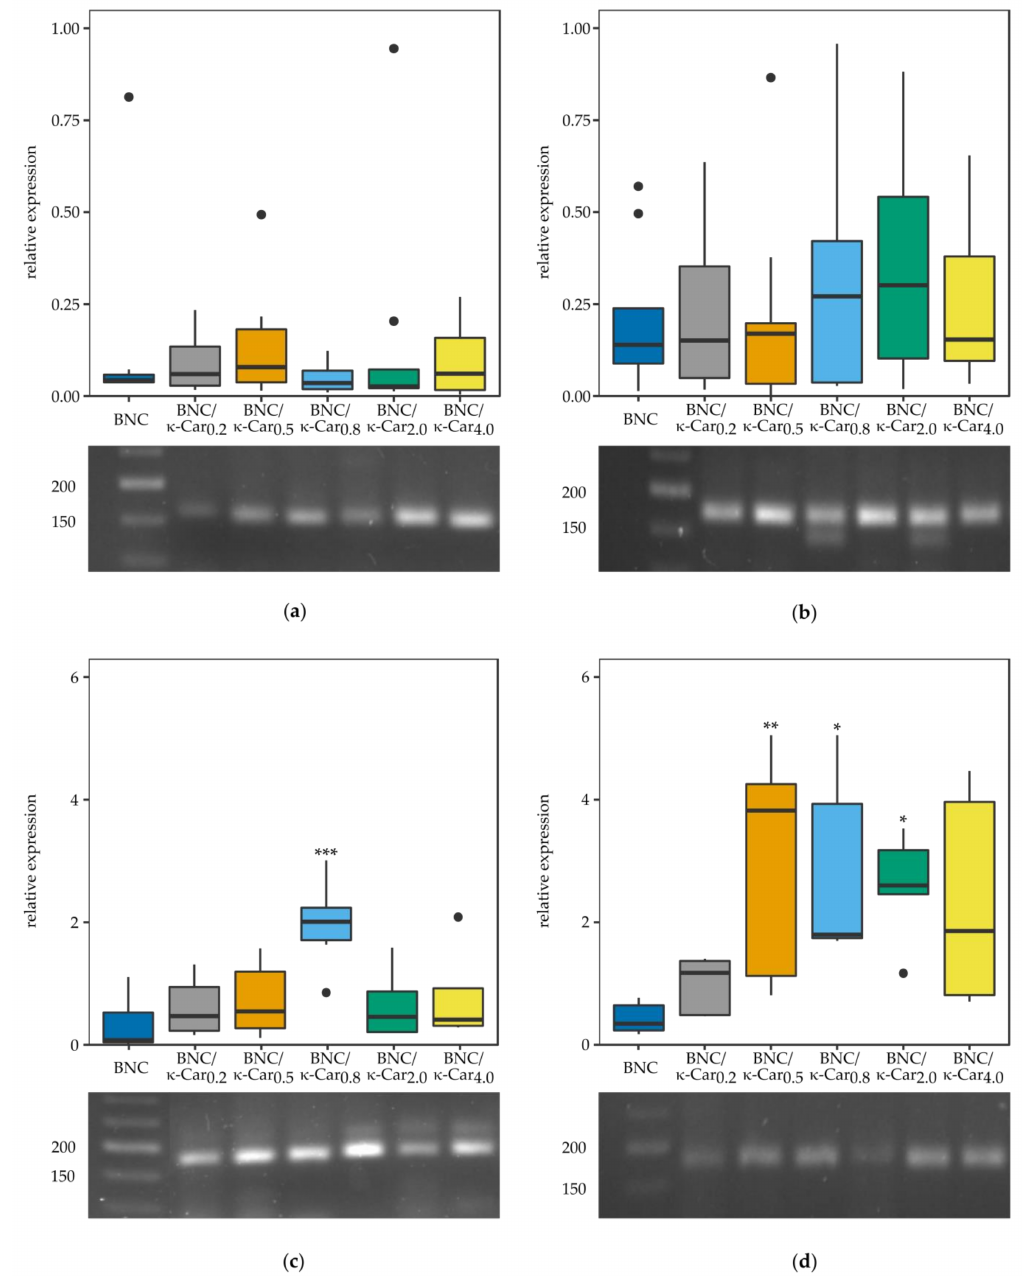
Figure 9. The relative expression of selected genes involved in differentiation of the ATDC5 cell